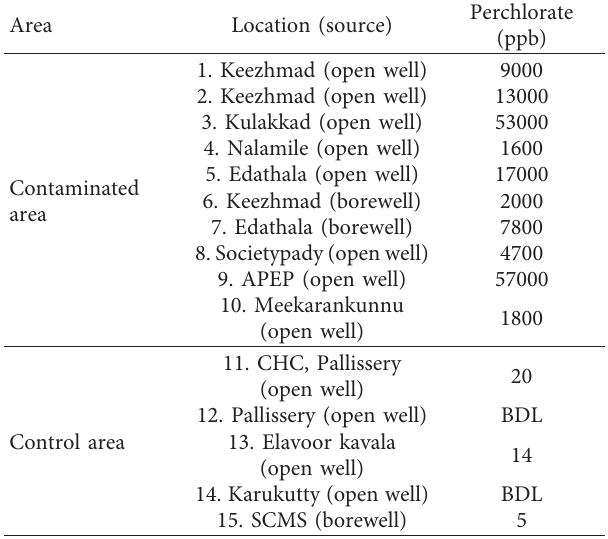
Table 2: Distribution of perchlorate concentration in groundwater samples from the study areas.